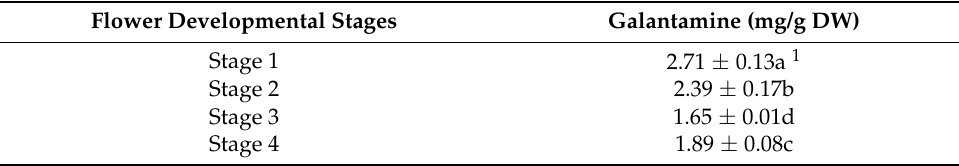
Table 2. HPLC analysis of galantamine in the different flowering stages of L . radiata .